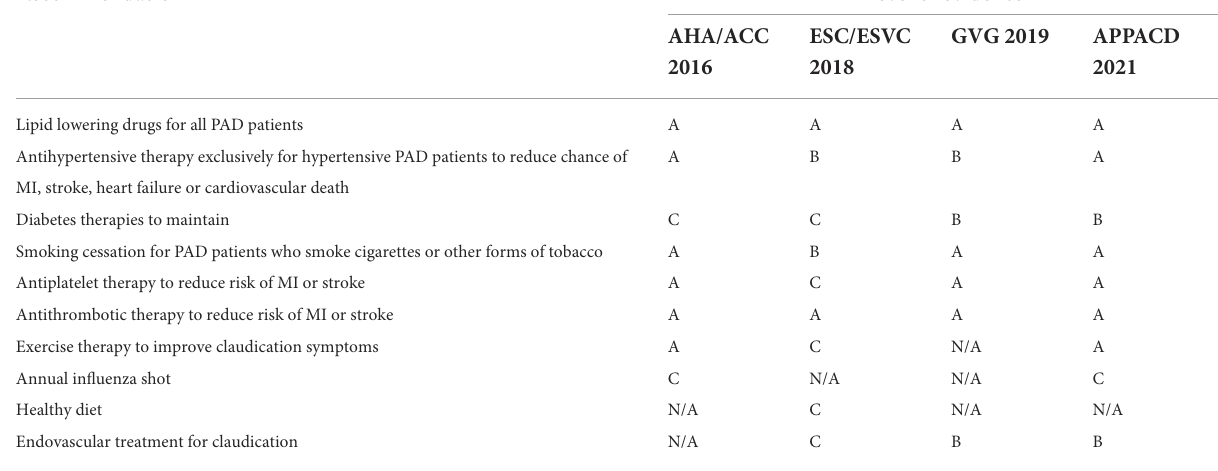
TABLE 1 Summary of Class I PAD treatment